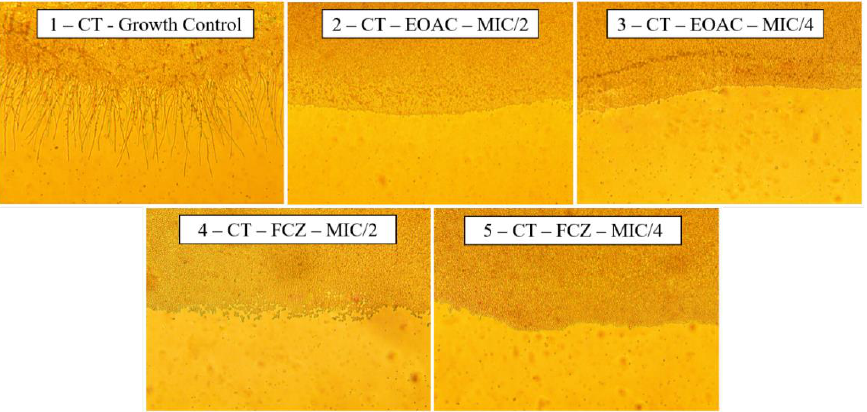
Figure 6. Effects of Acritopappus confertus essential oil on the morphological aspects of Candida tropicalis . Slide (S1): Growth control; (S2): Effect of essential oil at a concentration of 1024 µg/mL; (S3): Effect of essential oil at a concentration of 512 µg/mL; (S4): Effect of fluconazole at a concentration of 1024 µg/mL; (S5): Effect of fluconazole at a concentration of 512 µg/mL. Display 400× enlarged.